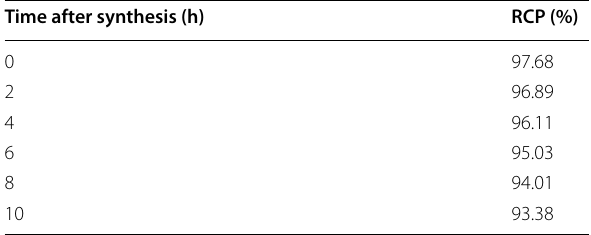
Table 2 In vitro stability test of 18 F-deoxy-thiamine Time after synthesis (h)